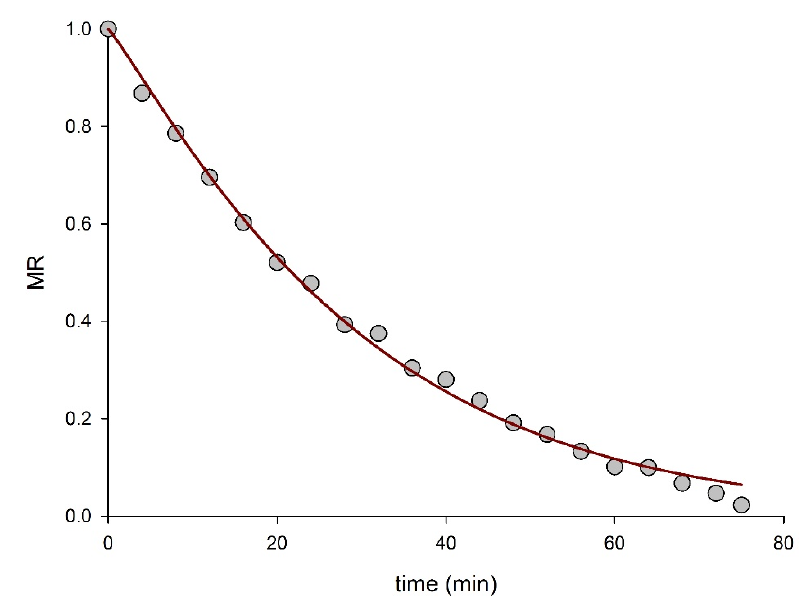
Figure 2. Drying data of peach slices at 60 °C (gray circles). Solid line indicates the fit of Page [Equation (1)] or modified Page [Equation (2)] model, where R 2 = 0.9960 and RMSE = 0.0192. Original data are from Zhu and Shen [19].